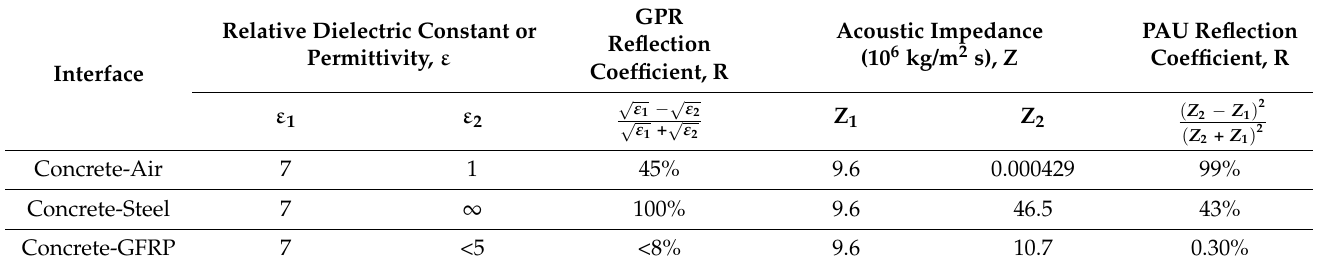
Table 6. Reflection coefficients for GPR and PAU